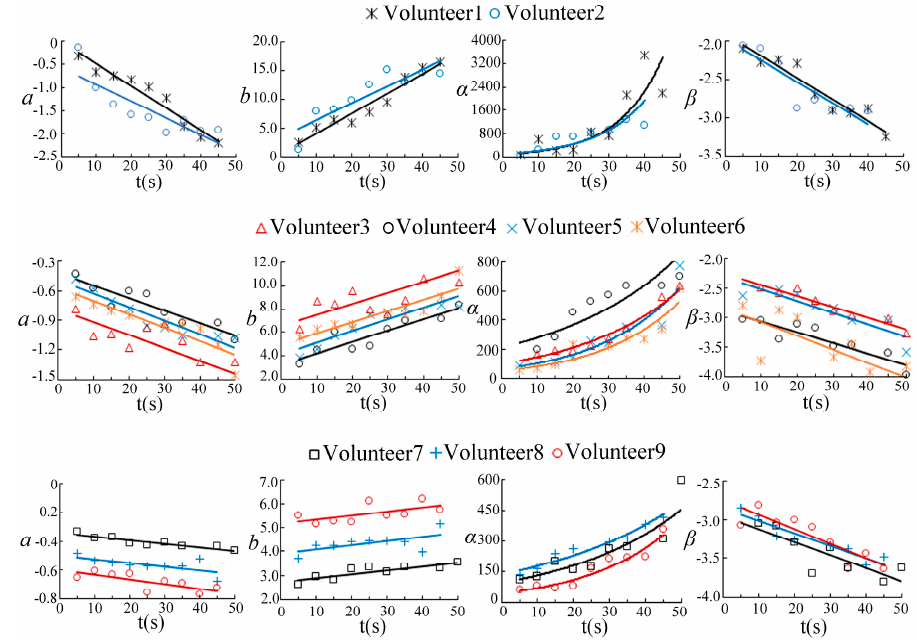
Figure 5. Changes in coefficients a , b , α , and β of each volunteer during the SC